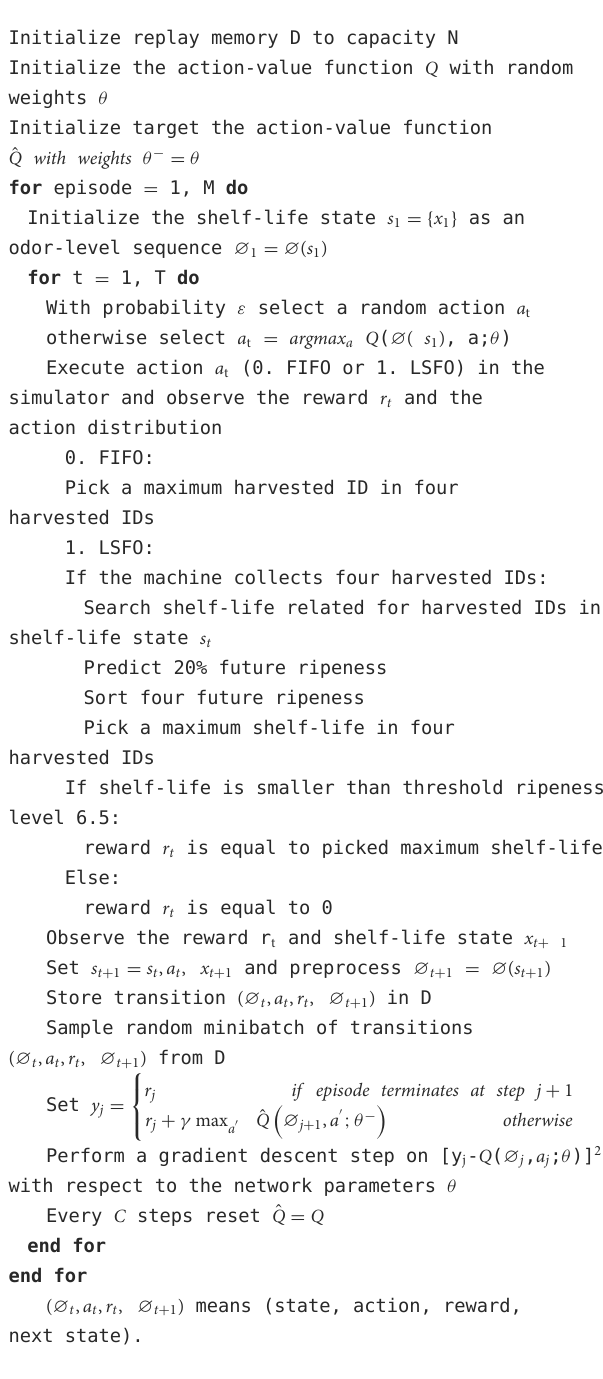
Algorithm 1. Deep learning